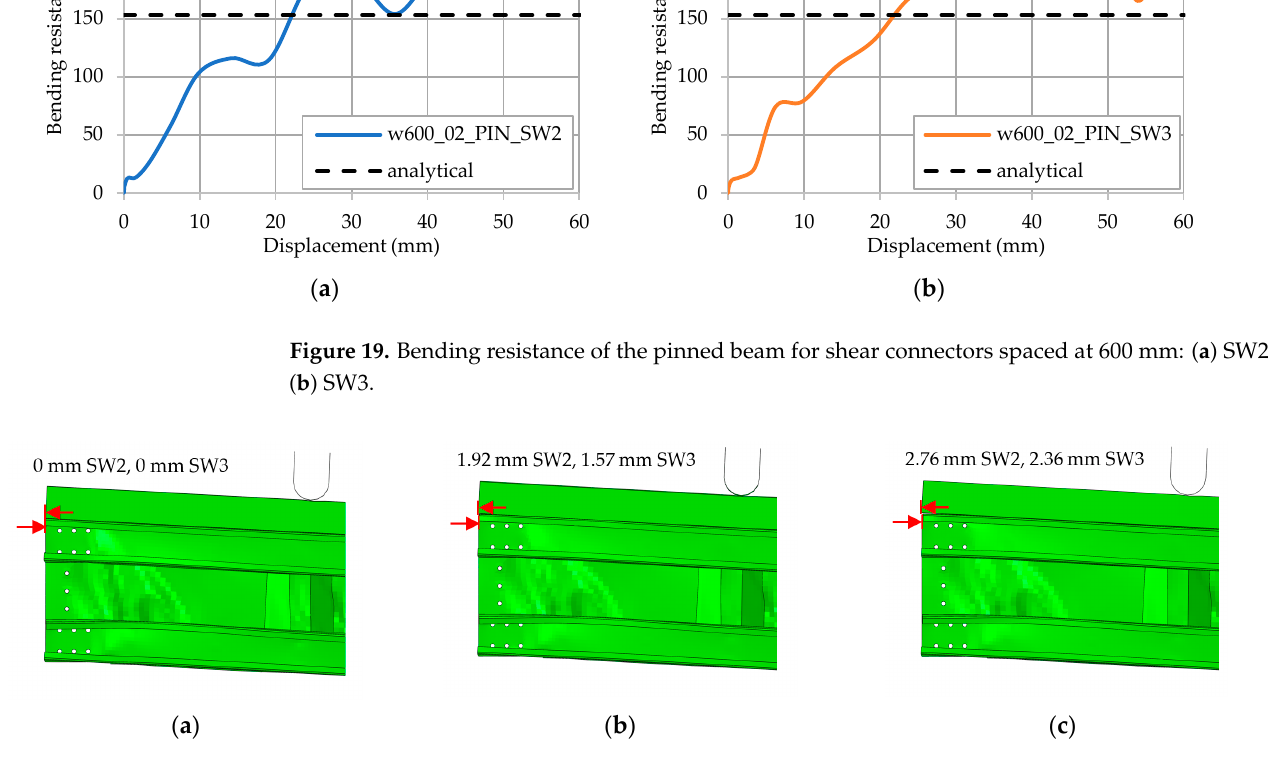
Figure 20. Differences in end slip between three analysed solutions of fixed beam: ( a ) full tie shear